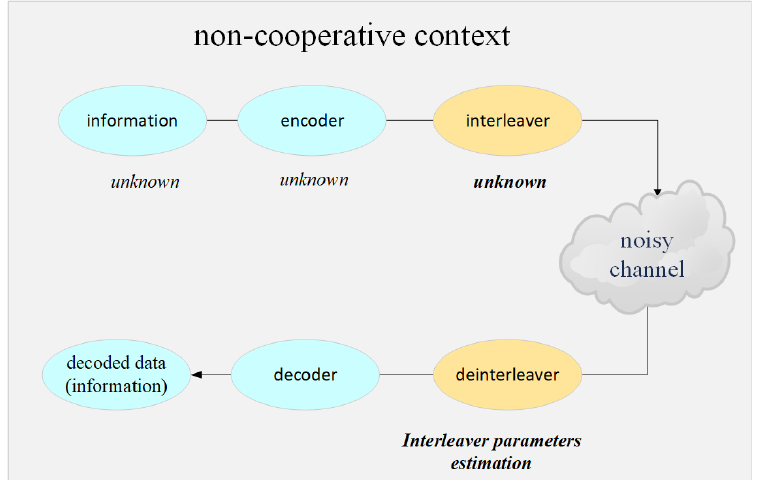
Figure 1. Illustration of the process of interleaver paramters